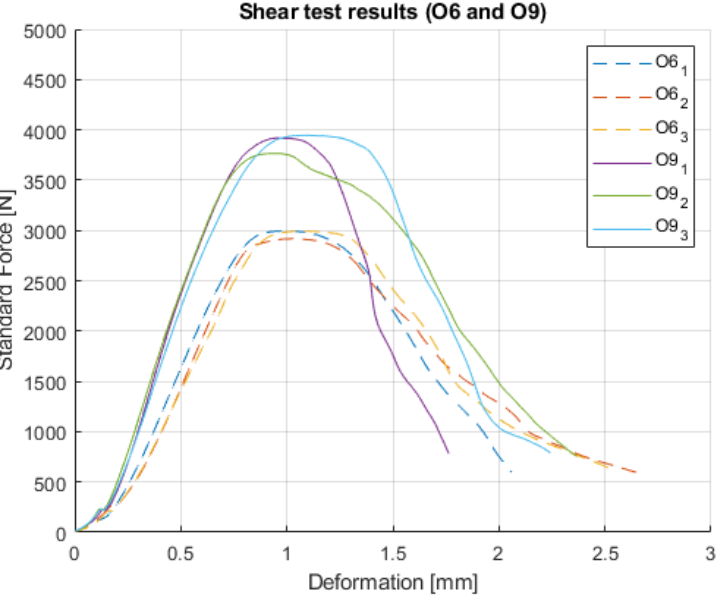
Figure 9. Results of O6 and O9.